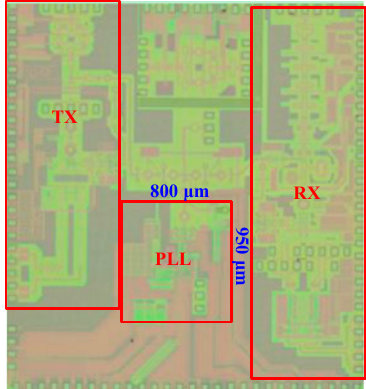
Figure 16. Photography of the 60 GHz CMOS transceiver with the integrated PLL. With a 108 MHz reference clock, by tuning division ratio of the MMD circuit, four typical clock frequencies (46.656, 48.384, 50.112, and 51.840 GHz) are generated, which correspond to four channel center frequencies of the 60 GHz band. Figure 17 shows the measured phase noise of these four frequencies. Clearly, benefiting from the above-mentioned design techniques of the VCO and frequency divider, the PLL can cover the four channels of the 60 GHz band, and the in-band phase noise is better than − 90 dBc/Hz at 100 KHz offset. Figure 18 shows the measured reference spur at the above-mentioned four channel center frequencies. As indicated, the spurious performance of the PLL is less than − 60 dBc.